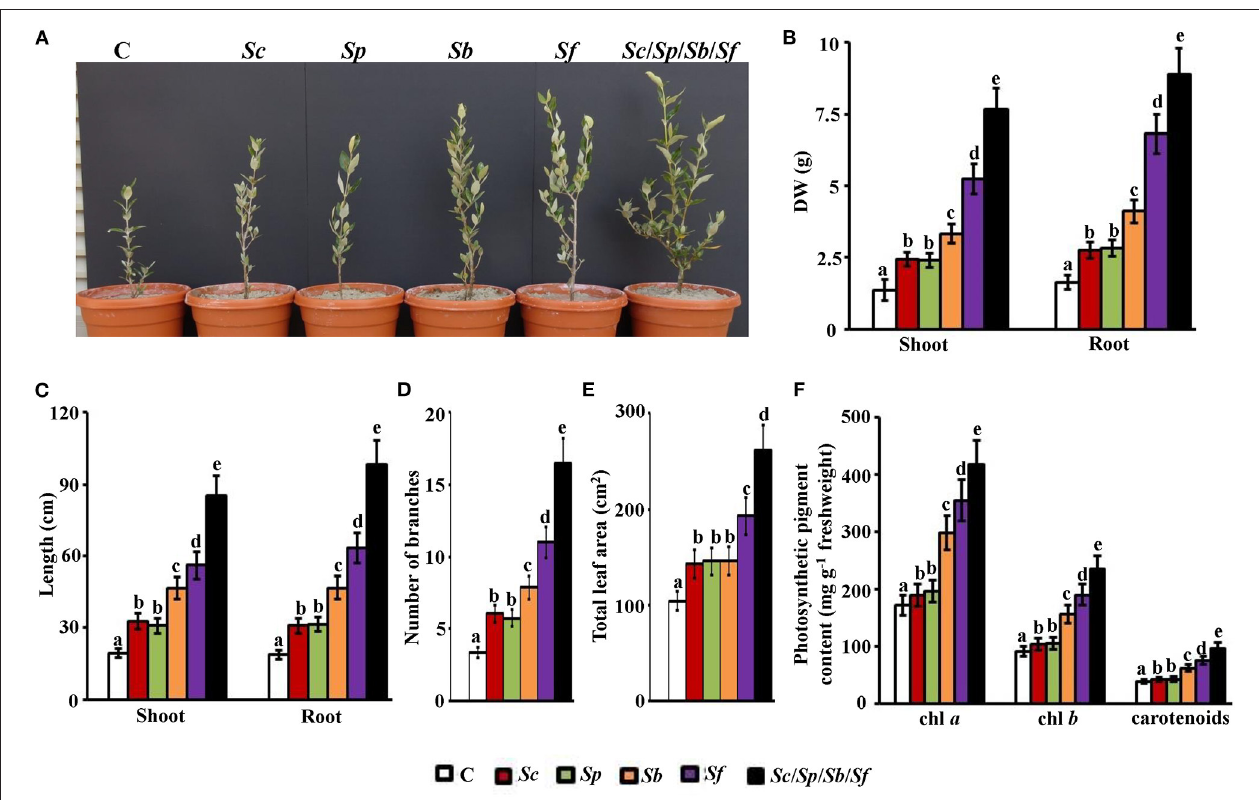
FIGURE 4 | Effect of the actinobacterial isolates on the growth and development of mangrove. Effect of the treatment of the P-solubilizing, auxin-, PAs-, and ACCD-producing isolates on the (A) performance; (B) DW; and (C) length of shoot and root tissues; (D) number of branches, (E) total leaf area, and (F) photosynthetic pigment contents of chl a , chl b , and carotenoids on mangrove seedlings. In (A–F) , the figure, dry weight and length of shoot and root tissues, number of branches, total leaf area, and photosynthetic pigments were measured at 9 months post planting the propagules of mangrove. Values are the means of 16 replicates for each sampling from two independent experiments. Mean values followed by different letters are significantly ( p < 0.05) different from each other according to Fisher’s Protected LSD Test. Bars represent SE. DW, dry weight; control (autoclaved non-inoculated oat bran); Sc , P-solubilizing isolate #2 ( Streptomyces coelicoflavus UAE2); Sp , auxin-producing isolate #15 ( Streptomyces polychromogenes UAE1); Sb , PAs-producing isolate #6 ( Streptomyces bacillaris UAE1); Sf , ACCD-producing isolate #37 ( Streptomyces ferrugineus UAE1); Sc/Sp/Sb/Sf, consortium of the four isolates. P, phosphorus; PAs, polyamines; ACCD, 1-aminocyclopropane-1-carboxylic deaminase; chl,